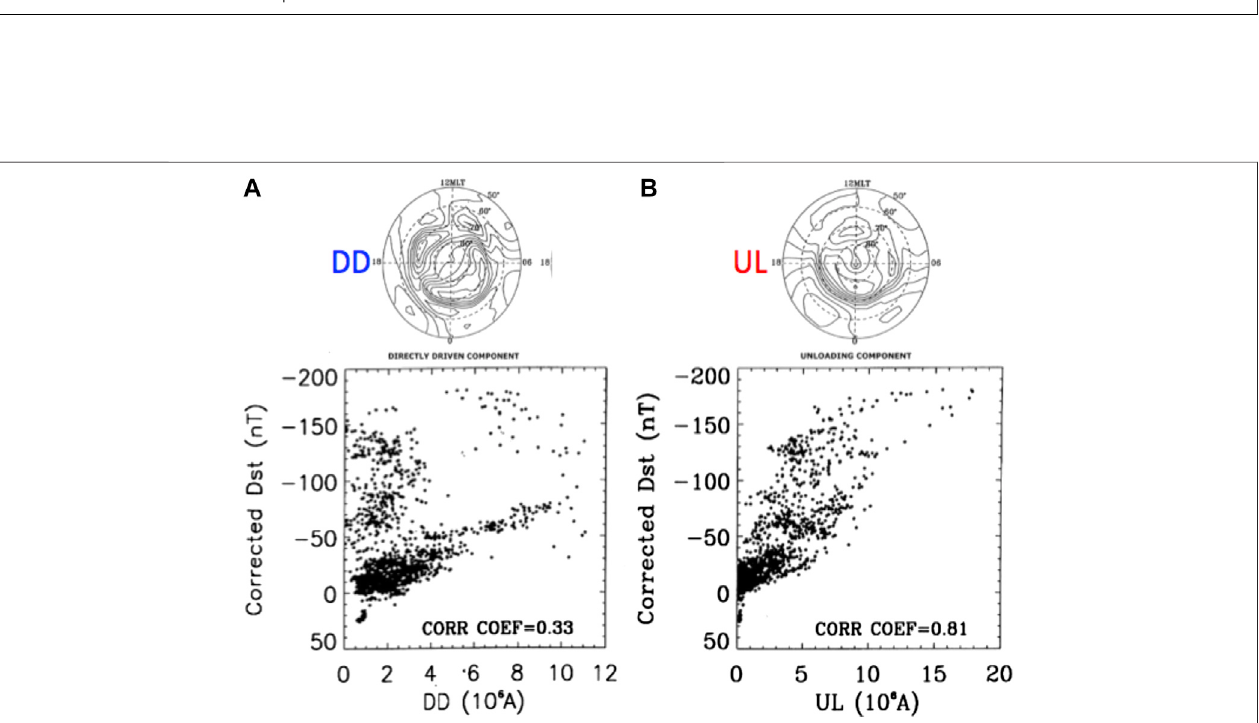
FIGURE 14 | (A) The relationship between the DD component and Dst. (B) The relationship between the UL component and Dst. (Sun and Akasofu, 2000).